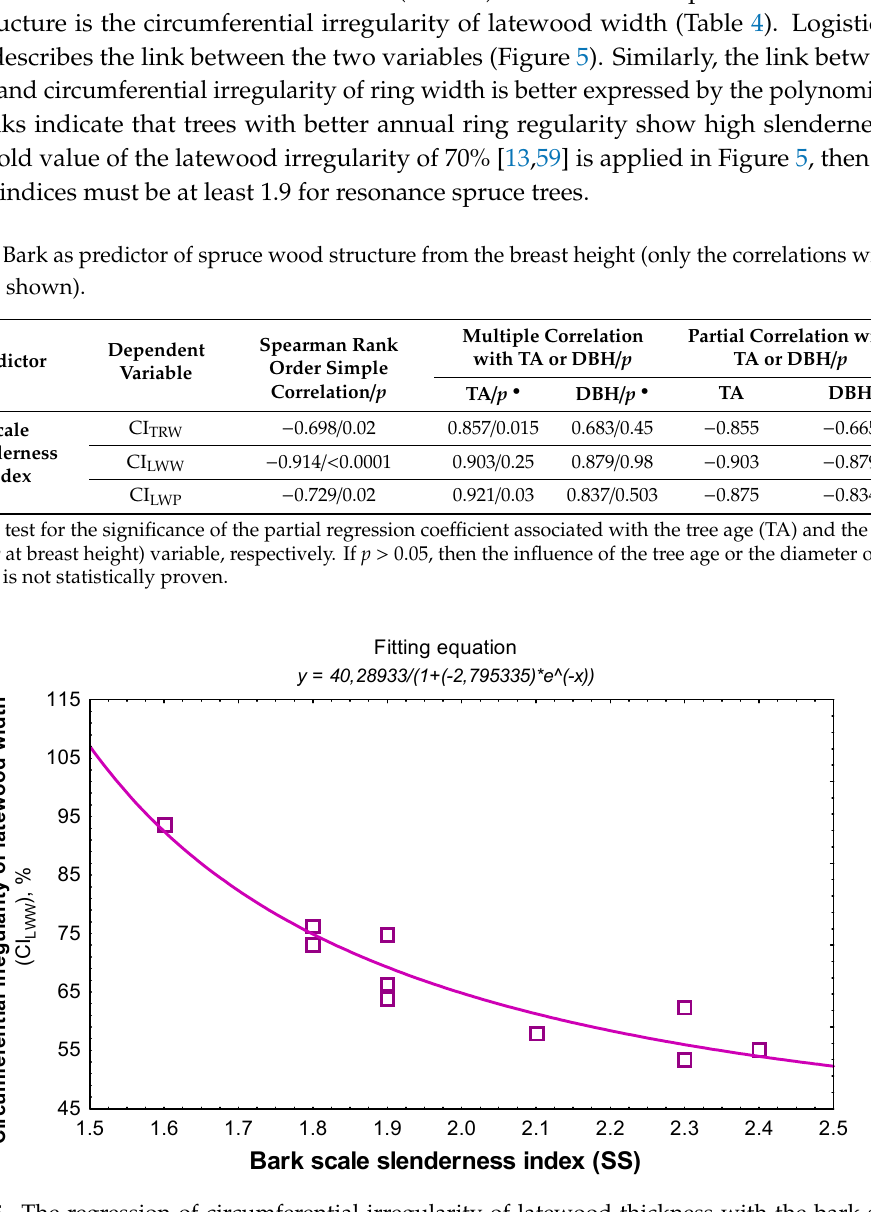
Figure 5. The regression of circumferential irregularity of latewood thickness with the bark scale slenderness index in trees sampled with slenderness index in trees sampled with discs.